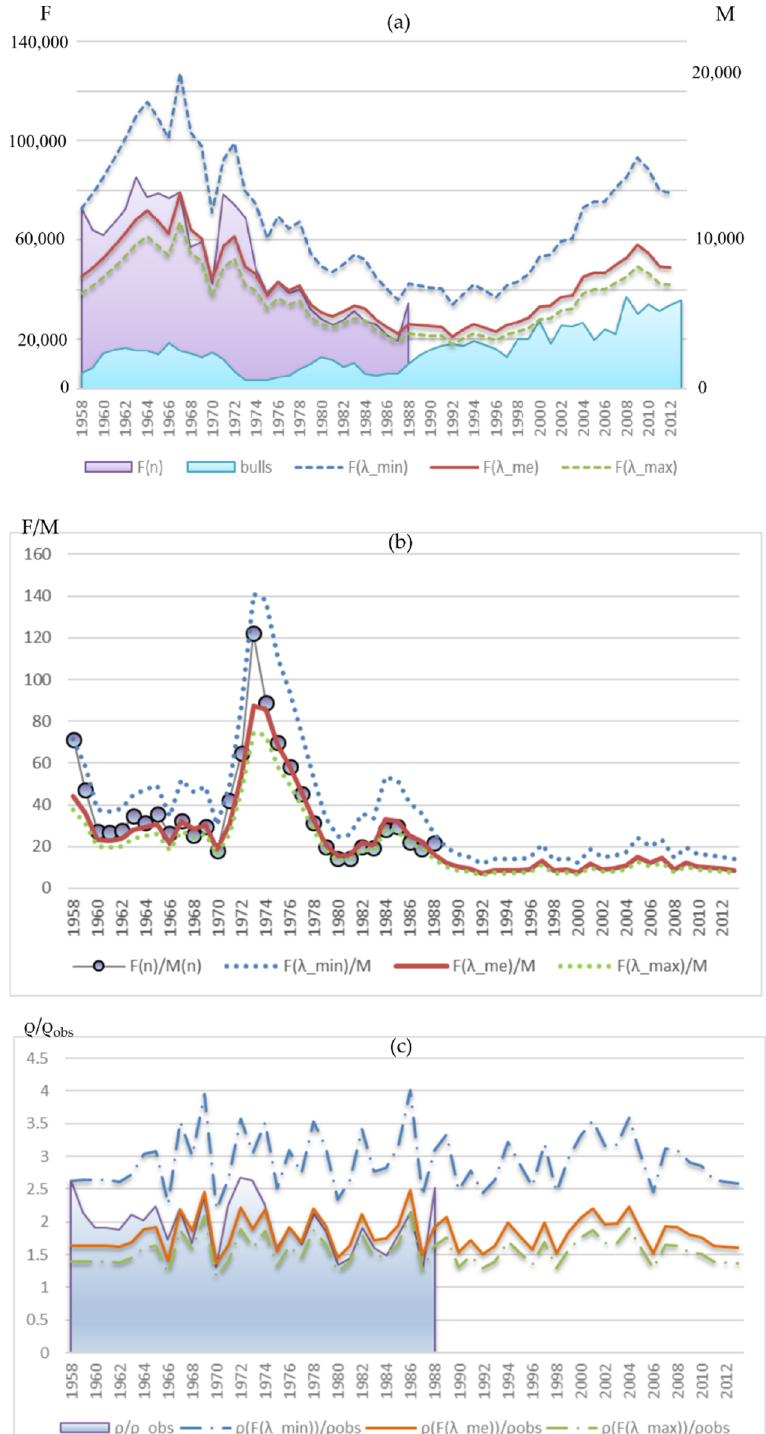
Figure 11. ( a ) Dynamics of the upper F ( λ min ), median F ( λ me ) and lower F ( λ max ) estimates of the total number of mature females in the population for each observation year, Equation (3); dynamics of females’ number estimates from marine samples F ( n ) for 1958–1988 (on the left axis), and the number of bulls at the rookery M ( n ) (on the right axis). ( b ) Dynamics of sex ratio F ( n )/ M ( n ) according to observations for the period 1958–1988 and sex ratios corresponding to the upper, median, and lower estimates of the females’ number for the entire period. ( c ) The difference dynamics between calculated sex ratios and that observed at the rookery.